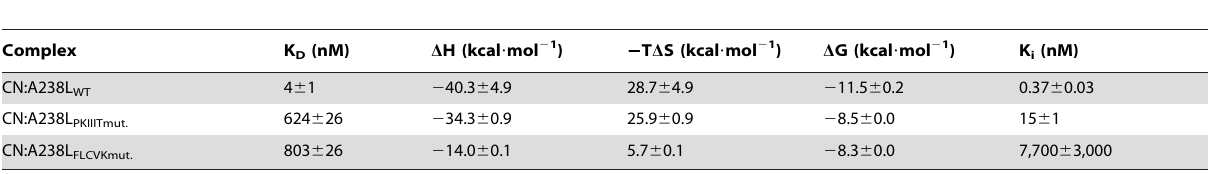
Table 1. Thermodynamic parameters and dissociation (K D ) and inhibition (K i ) constants for CN A1–391/B1–170 with A238L 200–239 wild- type, and A238L PxIxIT and LxVP mutants, derived from ITC experiments at 25 u C or enzyme assays performed with RII at 37 u C.